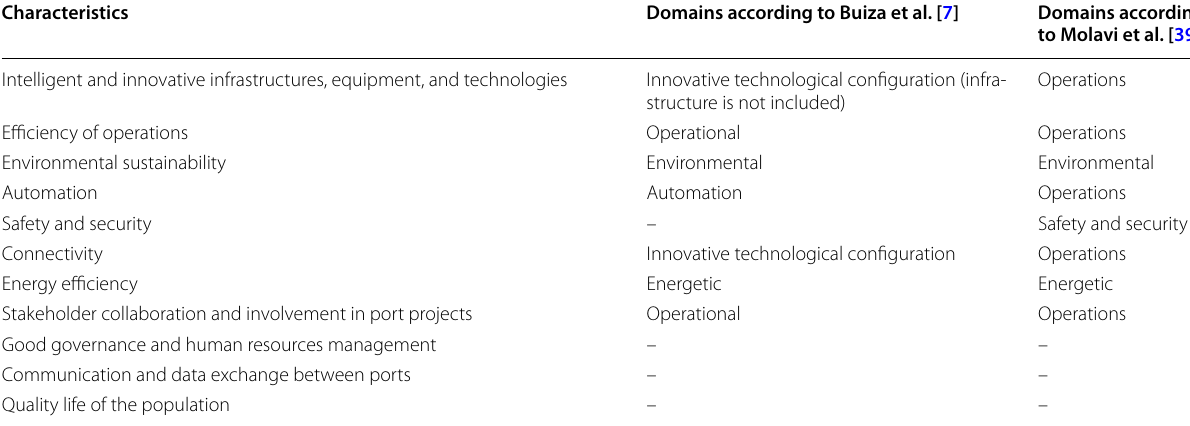
Table 5 Attribution of features grouped according to domains by Buiza et al. [7] and Molavi et al. [39] Characteristics